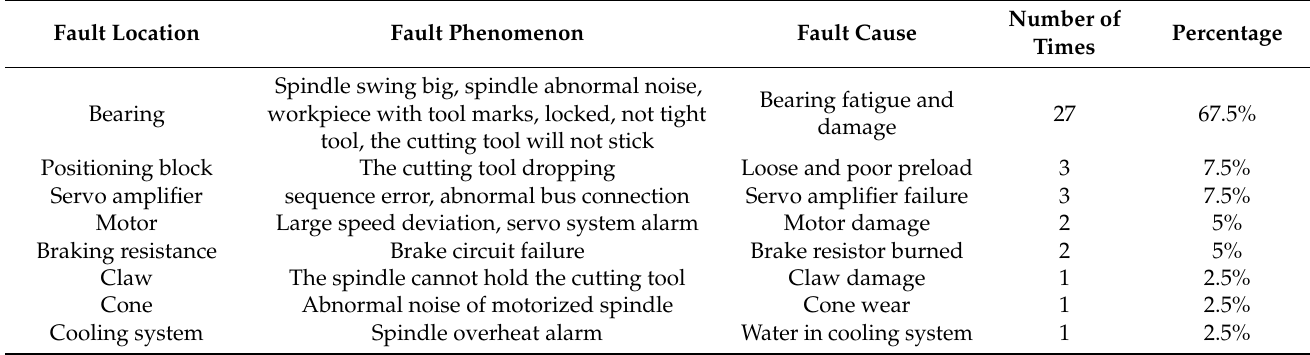
Table 1. Failure of motorized spindle system in field reliability test.